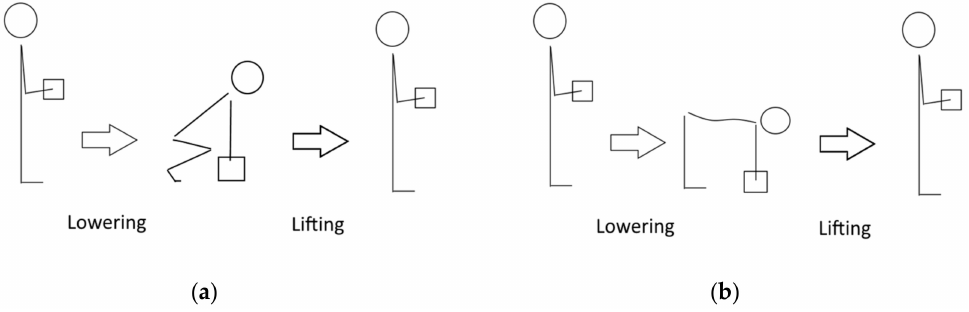
Figure 1. ( a ) Squat lifting and ( b ) stoop